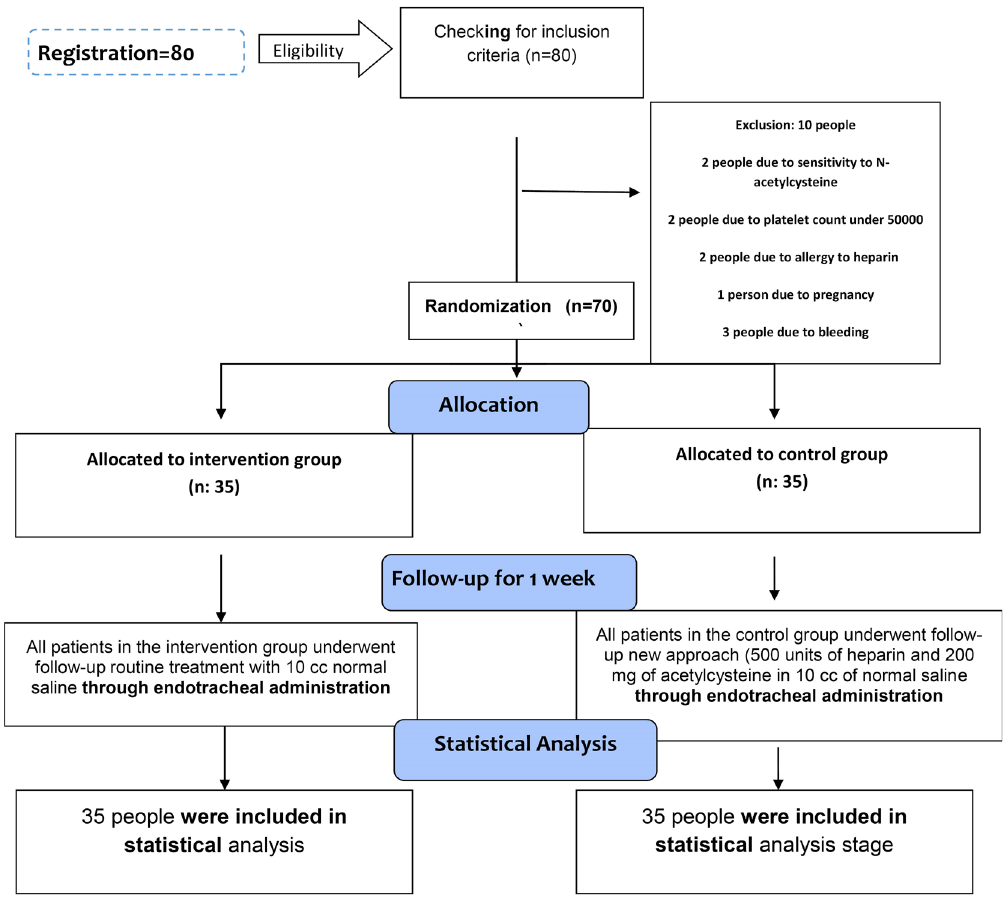
Figure 1. Consort Flowchart of the